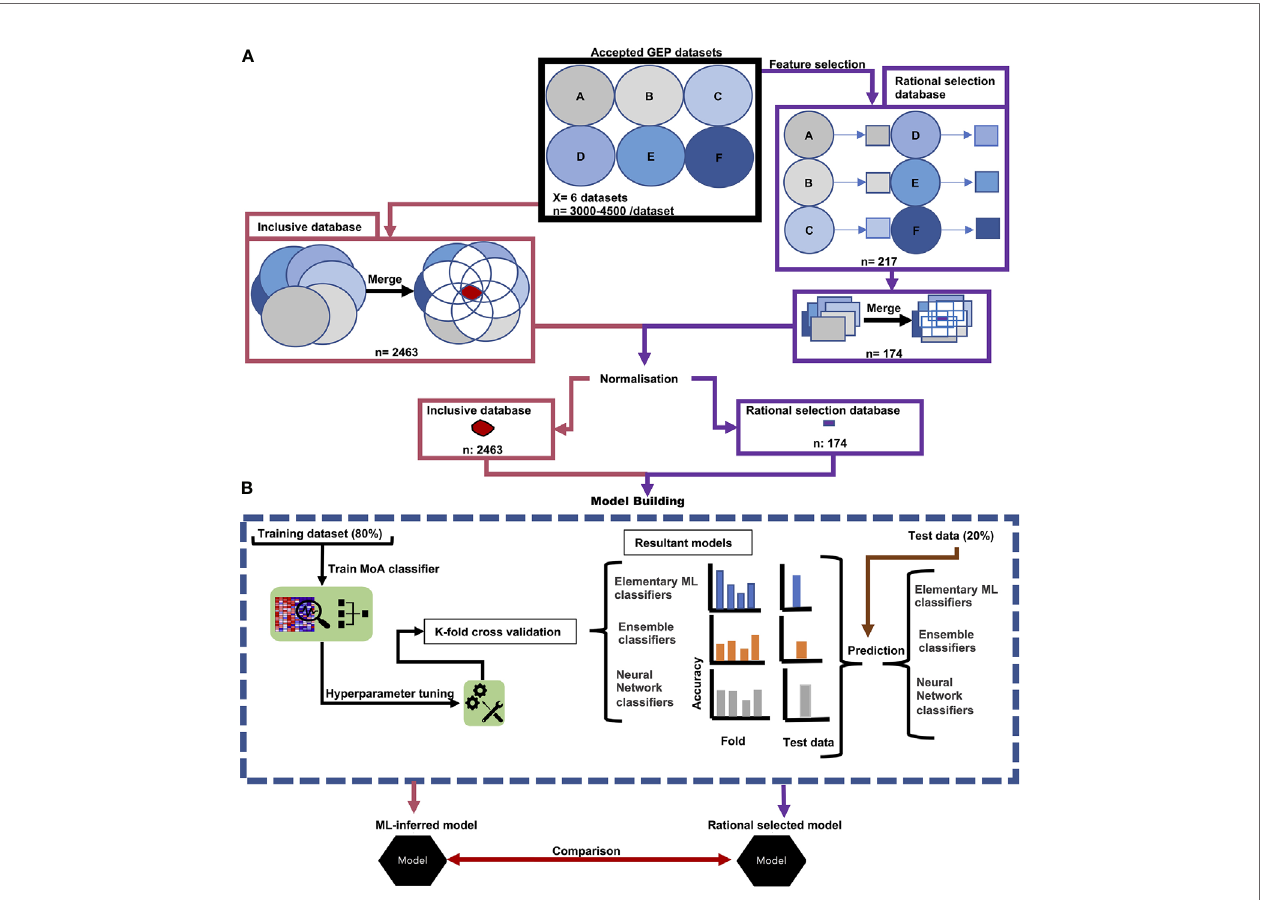
FIGURE 1 | Work fl ow of data acquisition and model building. (A) Accepted GEPs of treated P. falciparum formed our inclusive database (pink) and underwent feature-selection (purple). In both instances the GEPs were merged and underwent normalization. The resultant transcripts from the (pink) accepted GEPs produced our inclusive database. Similarly, the consequential transcripts from our feature selection produced our rational selection database (purple). (B) Both transcripts in the inclusive database and in the rational selection database were used to separately build models. Treatment time points were randomly split at an 80/20 ratio, whereby 80% was used as a training set for model tuning, training and K-fold cross validation. The resultant 20% of treatment time points were used as a test set to evaluate model performance on untrained data. Prediction accuracy of treatment MoA from both the K-fold cross validation and prediction on the test set was used to determine the best classi fi cation algorithm for antiplasmodial MoA. From this classi fi cation algorithm, the resultant models trained on either the inclusive database or rational selection database were compared and assessed which selection approach was the best in identifying the minimum number of transcripts for robust MoA prediction using a sliding gene-scale